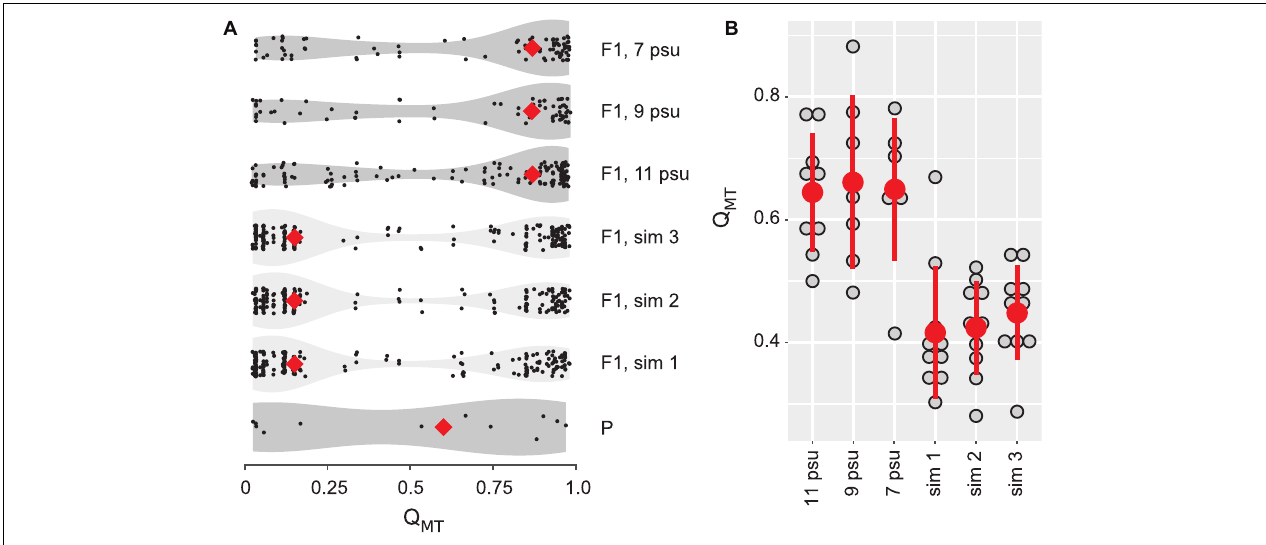
FIGURE 4 | Distribution of hybrid classes expressed as Q MT -values among parental animals (AHP-P), pooled simulated reference populations (AHP-F1 sim 1–3), and pooled treatment data at different salinities (AHP-F1_7psu, AHP-F1_9psu, AHP-F1_11psu). (A) Violin plots represent the distribution of individual Q MT -values and medians (red diamonds). (B) Comparison between experimental (AHP-F1) and simulated offspring (AHP-F1-sim) populations depicting culture (replicate) bottle mean Q MT -values (grey dots), with temperatures pooled for each salinity step, overall treatment mean values (red dot) and